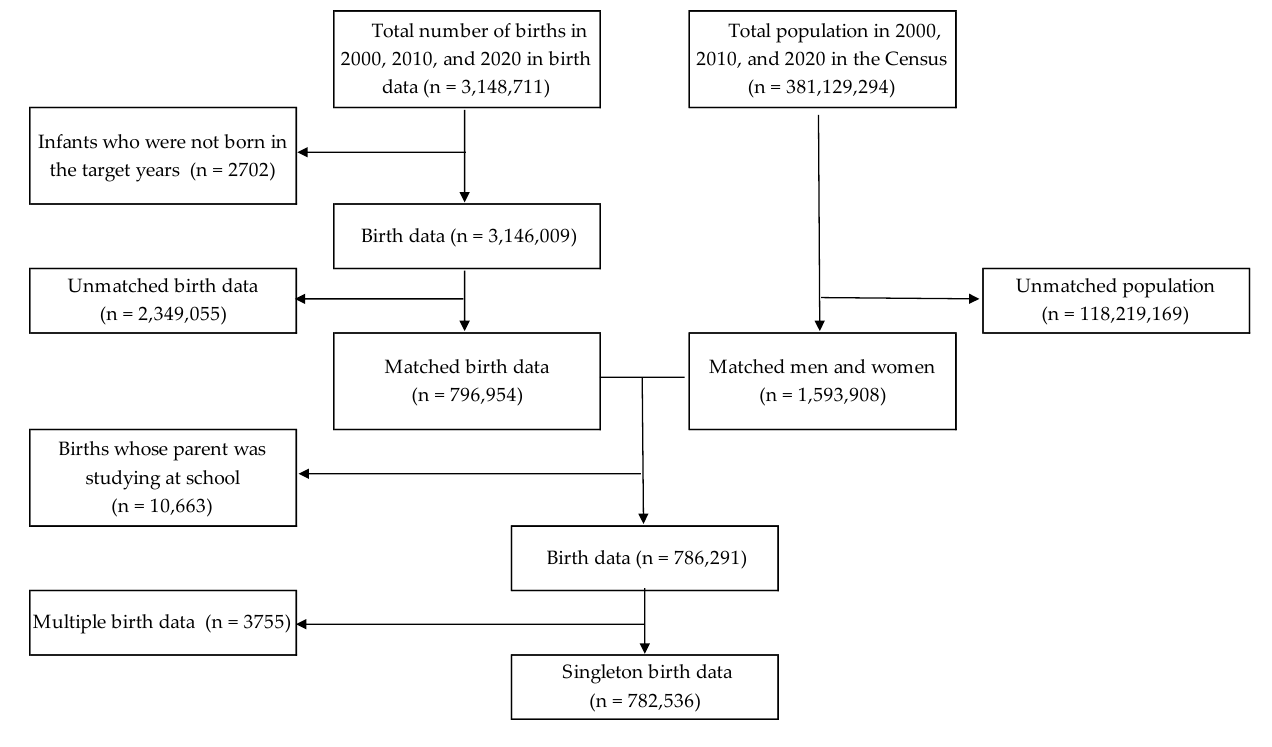
Figure 1. The flowchart of the data selection.